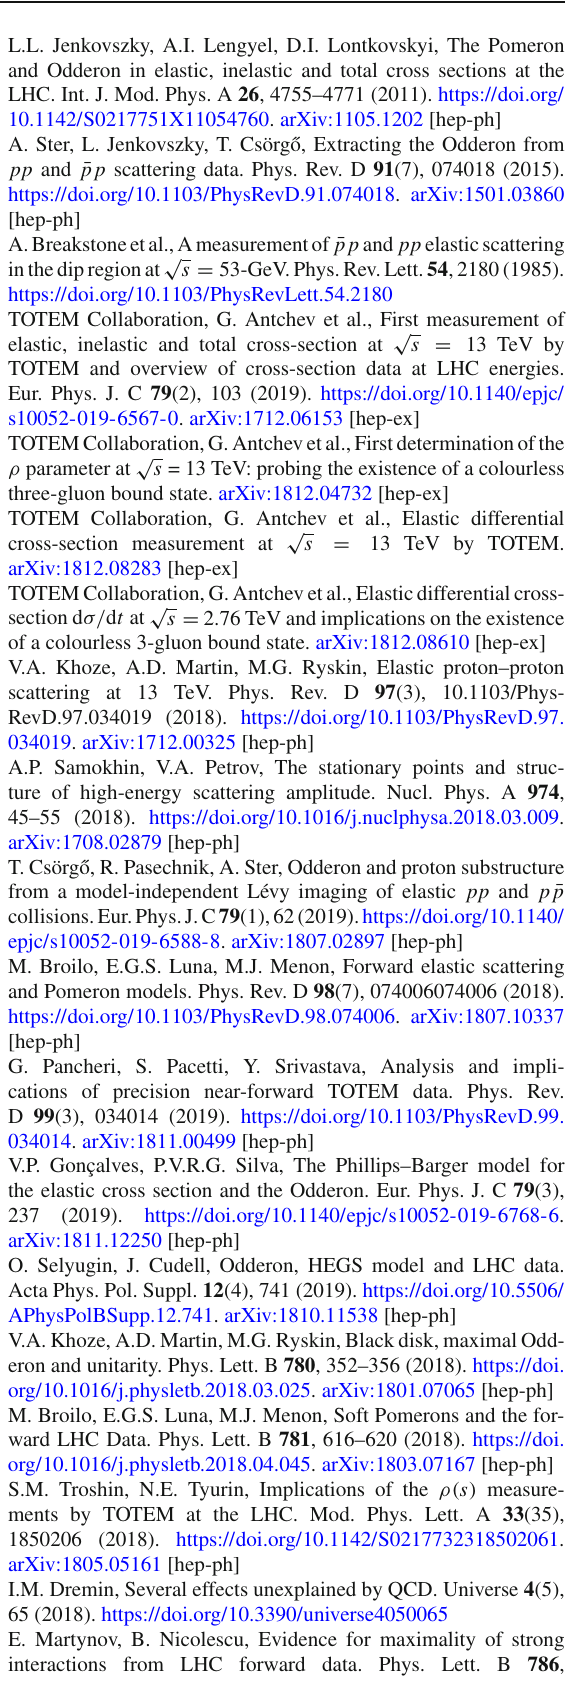
included, the linear approximation in the energy region of √ s ≤ 8 . 0 TeV is completely 0 . 546 ≤